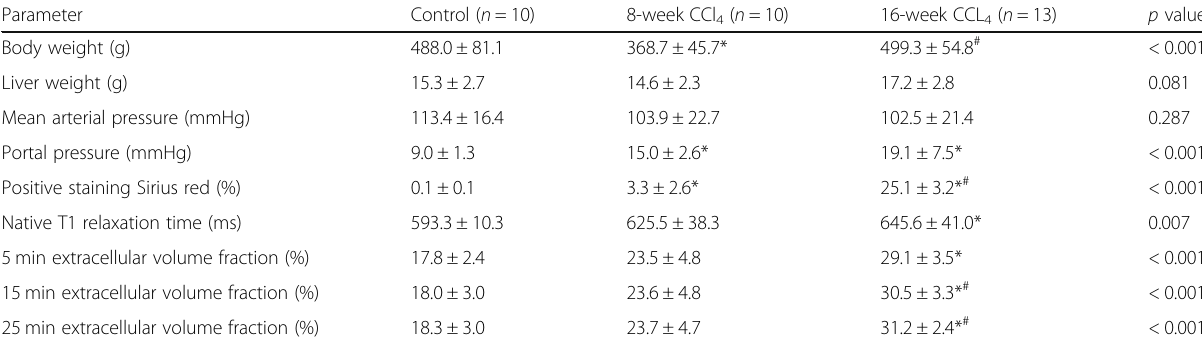
Table 1 General characteristic of different groups of CCL 4 rats